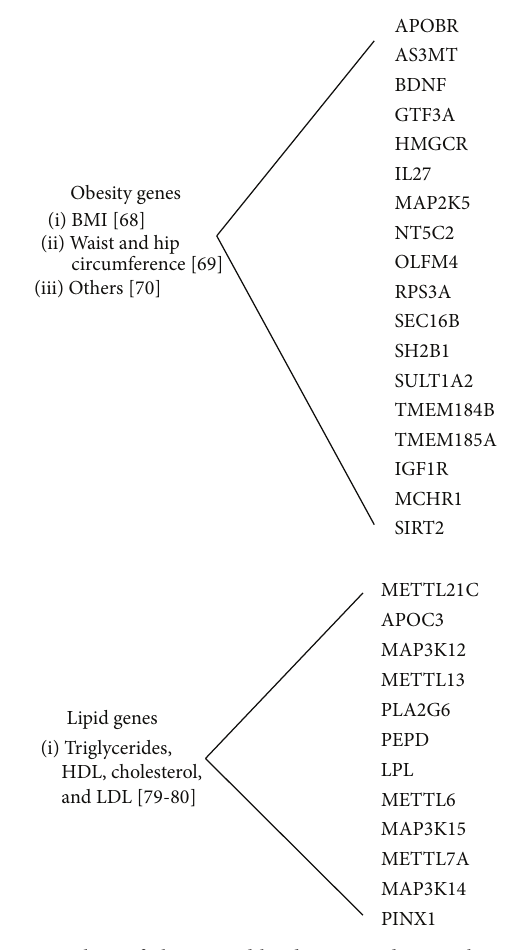
Figure 4: Subset of obesity and lipid associated genes that possess in silico identified FXR